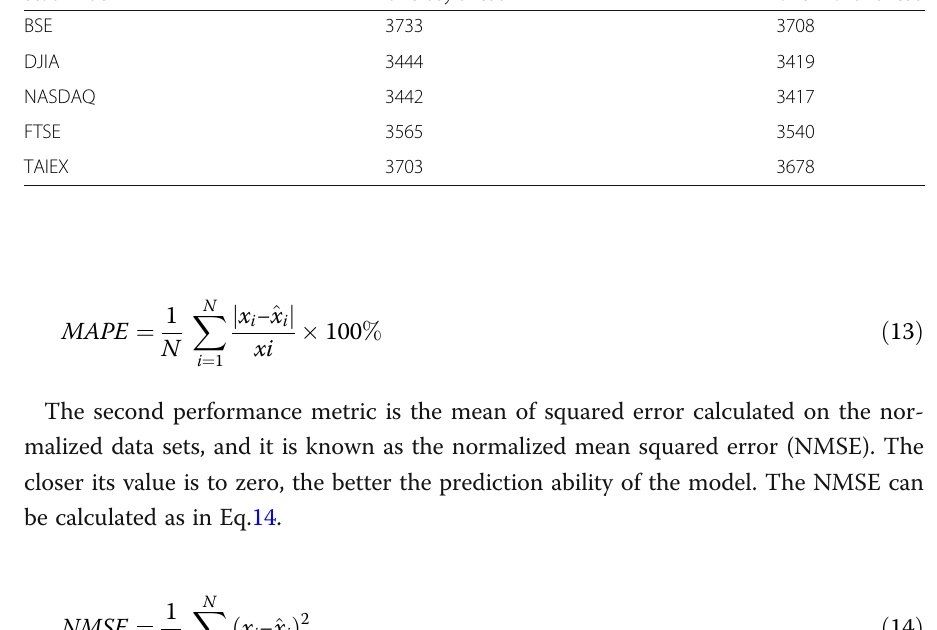
Table 5 Number of windows generated for each category of prediction Stock